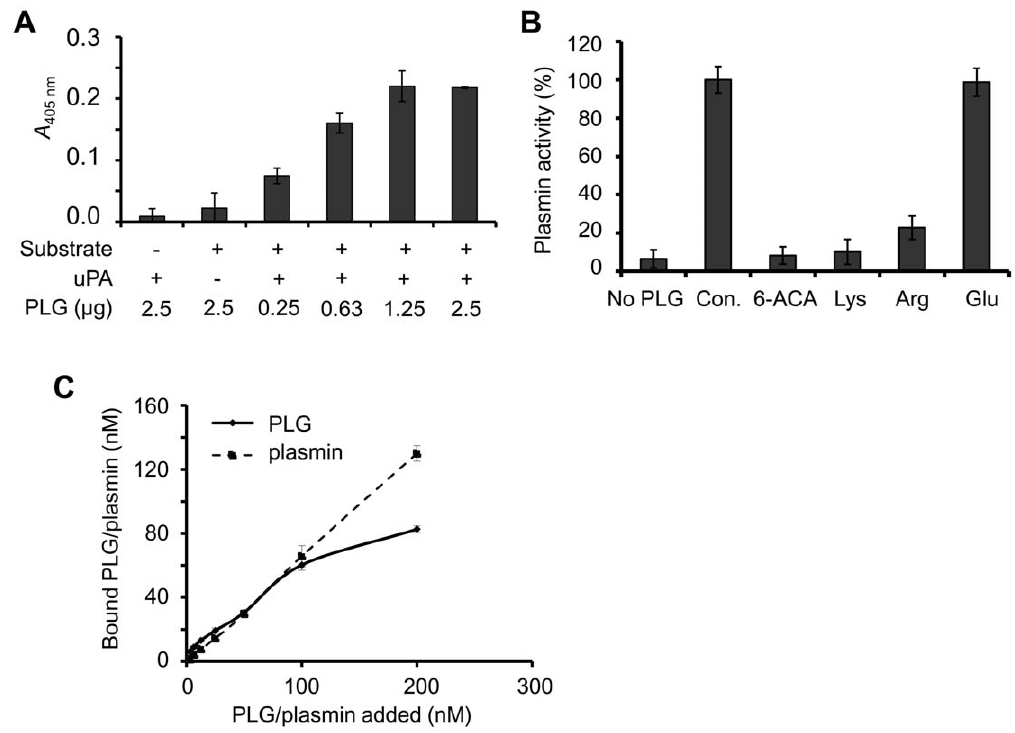
Figure 3. Spore-bound PLG is activated by uPA. (A) Plasmin activity of bound PLG after uPA activation. Spores (5 6 10 7 ) were incubated with PLG and washed, and 20 units of uPA and plasmin substrate VLK-pNA were added. After incubation for 15 min at room temperature, the absorbance was measured at 405 nm. (B) Effect of lysine analogues on spore-bound PLG/plasmin activity. Spores (5 6 10 7 ) were incubated with PLG (2 m g) in the presence of 50 mM amino acids, and assayed as described in panel A . (C) Binding affinity of PLG and plasmin to spores. PLG and plasmin were incubated with spores (2.4 6 10 7 ) and the amount of bound proteins was assayed by the colorimetric method described in panel B. The amount of plasmin was determined using a standard activity curve.